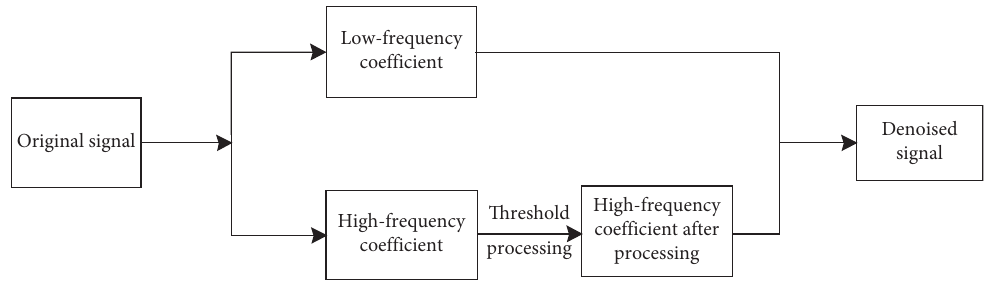
Figure 1: Wavelet threshold denoising